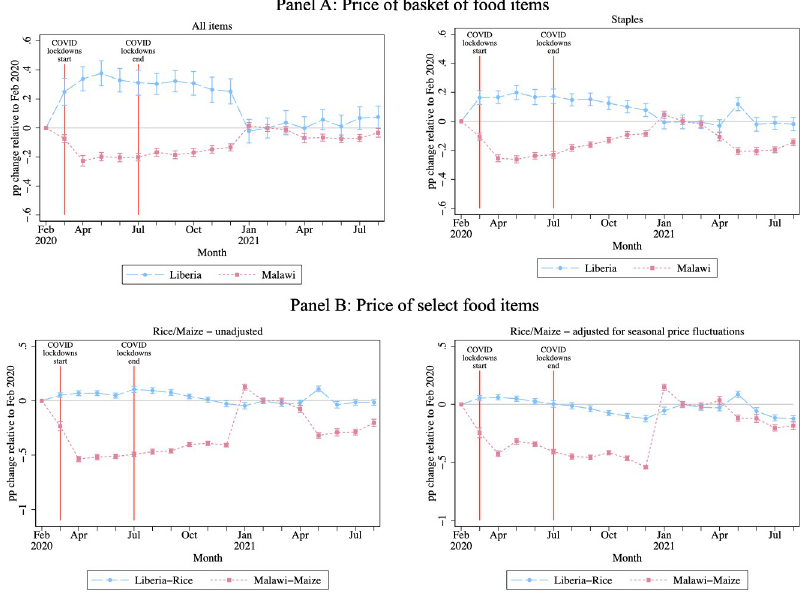
Fig 3. Effect on crop prices. Note: The unit of observation is the market-month. There are 95 markets and 13 products in Malawi and 85 markets and 10 products in Liberia. The figure presents coefficients from a regression on ratio of price to price in February of same year, omitting the reference period of February 2020. All monetary values are in USD and Winsorized at 1% and 99%. Standard errors are clustered at the market level. See text for crops included in analysis. Panel B shows (imported) rice and maize prices, with and without subtracting off monthly average relative prices from the WFP data (only available for these two products). All specifications include market fixed effects ans standard errors clustered at market level. Regressions for staples additionally include product fixed